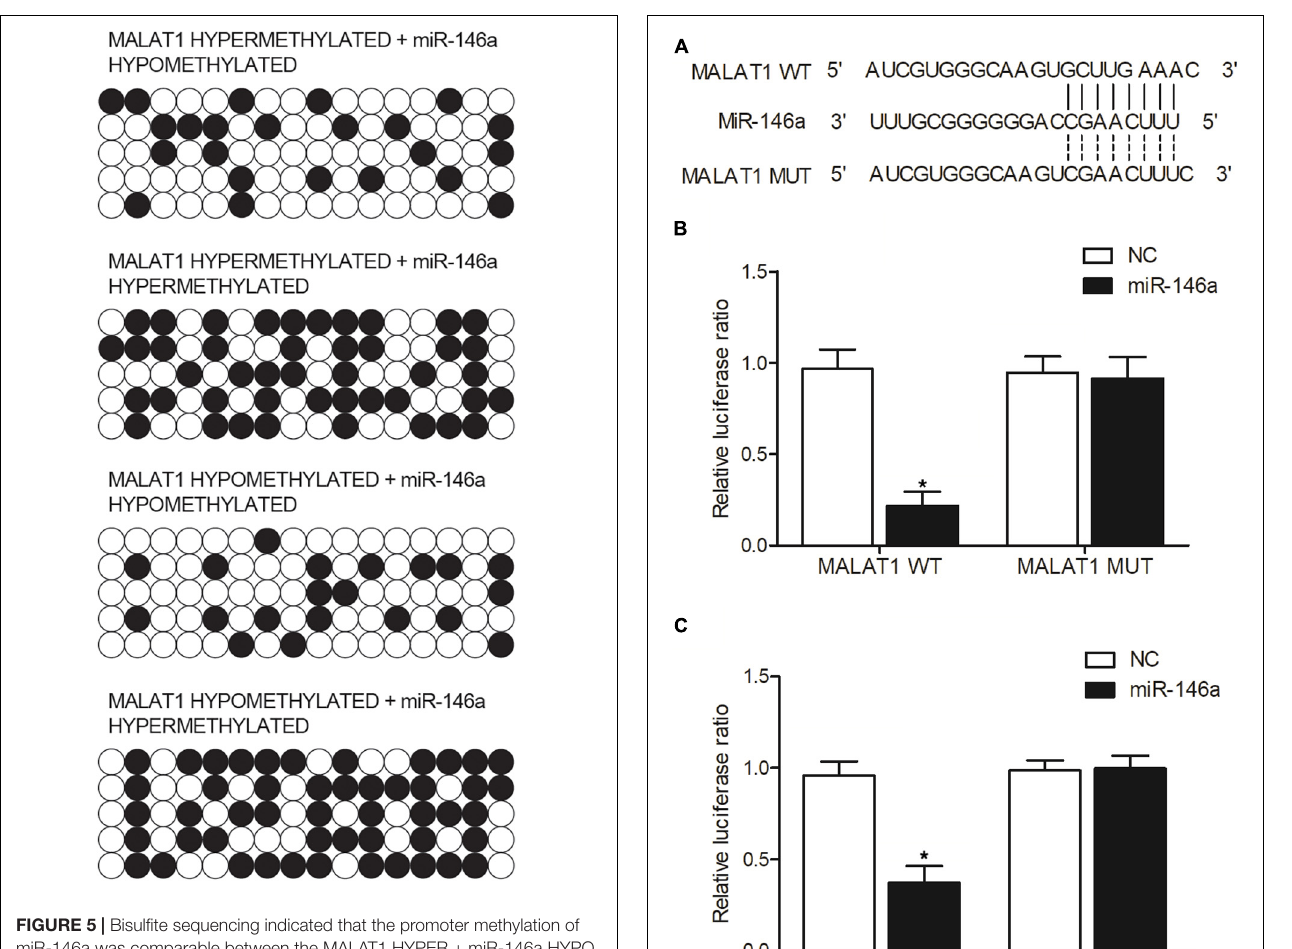
FIGURE 5 | Bisulfite sequencing indicated that the promoter methylation of miR-146a was comparable between the MALAT1 HYPER + miR-146a HYPO group and the MALAT1 HYPO + miR-146a HYPO group, as well as between the MALAT1 HYPER + miR-146a HYPER group and the MALAT1 HYPO + miR-146a HYPER group. FIGURE 6 | MALAT1 was targeted by miR-146a (* p < 0.05 vs. NC group).